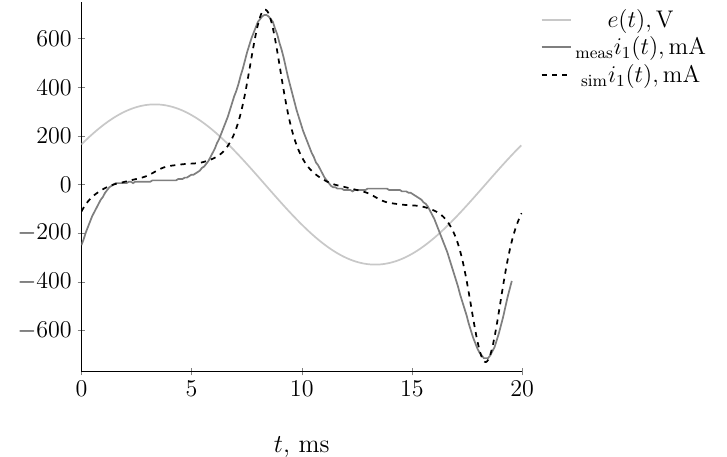
Figure 13. Voltage and current records (measured and simulated) for the steady-state operation of the unloaded transformer. The current is expressed in mA, and the scale of the y-axis is common for the current (mA) and voltage (V).